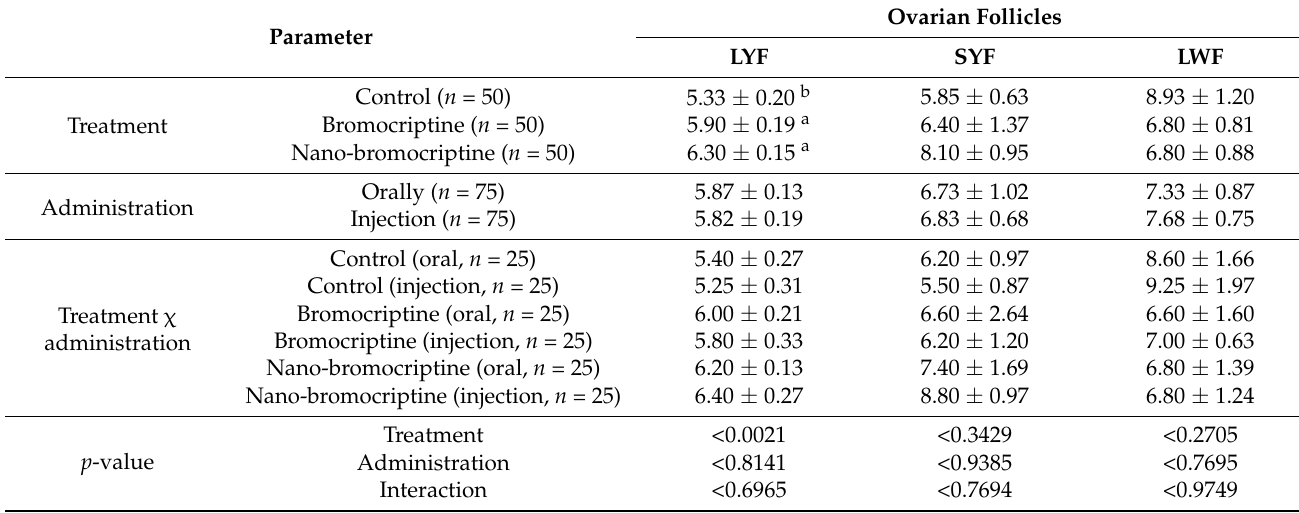
Table 3. Effects of bromocriptine and nano-bromocriptine on ovarian follicles of late laying hens.